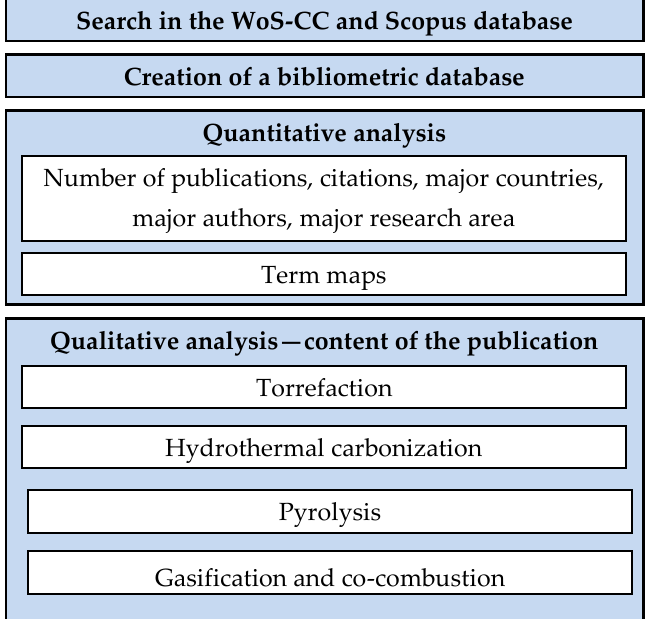
Figure 3. Diagram of research methodology.